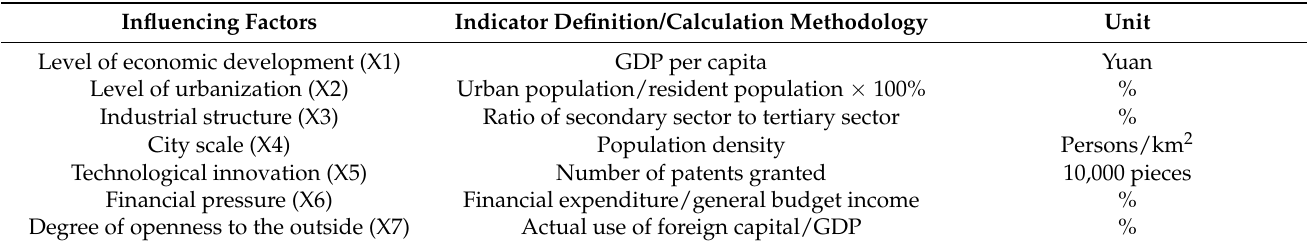
Table 2. Index selection of factors influencing urban ecological welfare